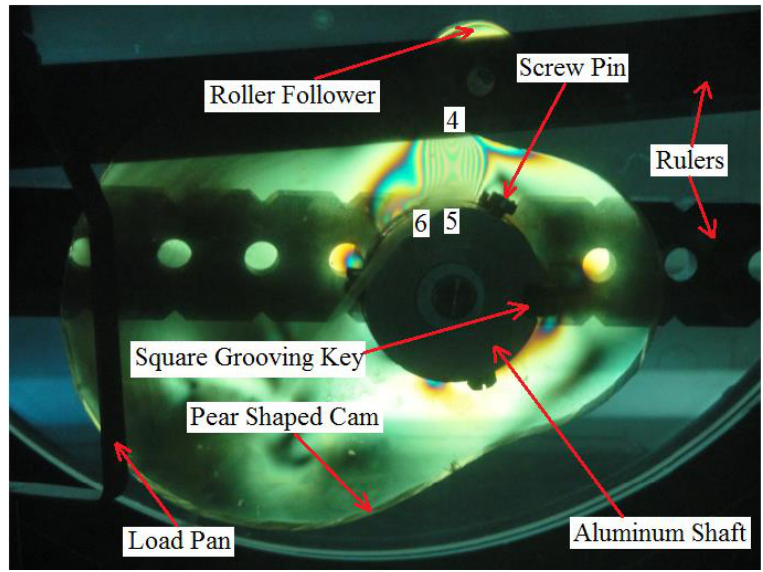
Figure 13. Experimental analysis of the stress distribution when the follower comes in contact with flank no.(1).